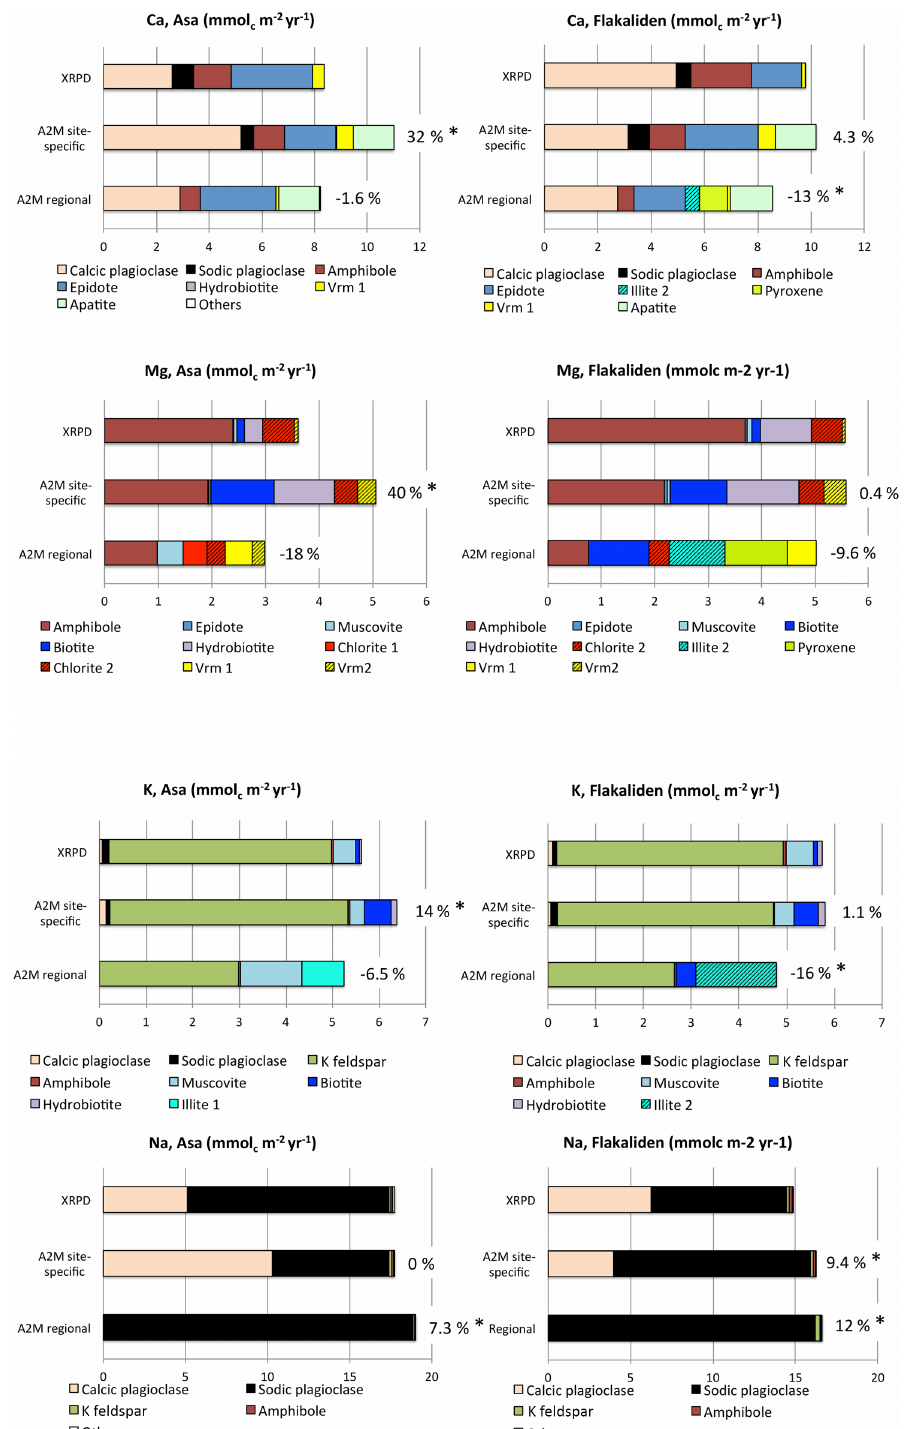
Figure 5. Comparison of sums of PROFILE base cation weathering rates for different minerals in the upper mineral soil (0–50cm) based on XRPD mineralogy and the average PROFILE base cation weathering rate (i.e., based on 1000 input A2M mineralogies per mineral) according to the two normative mineralogical methods and for each study site (i.e., Asa site-specific, Flakaliden site-specific, Asa regional, Flakaliden regional). For W A2M , relative error (percentage of W XRPD estimate) is given at the end of each bar to illustrate the average deviation of W A2M and W XRPD in the upper mineral soil. The asterisk ( ∗ ) denotes a significant discrepancy as defined in Sect. 2.7. Vrm1 = trioctahedral vermiculite; Vrm2 = dioctahedral vermiculite. Information on chemical compositions of minerals are given in Tables S5 and